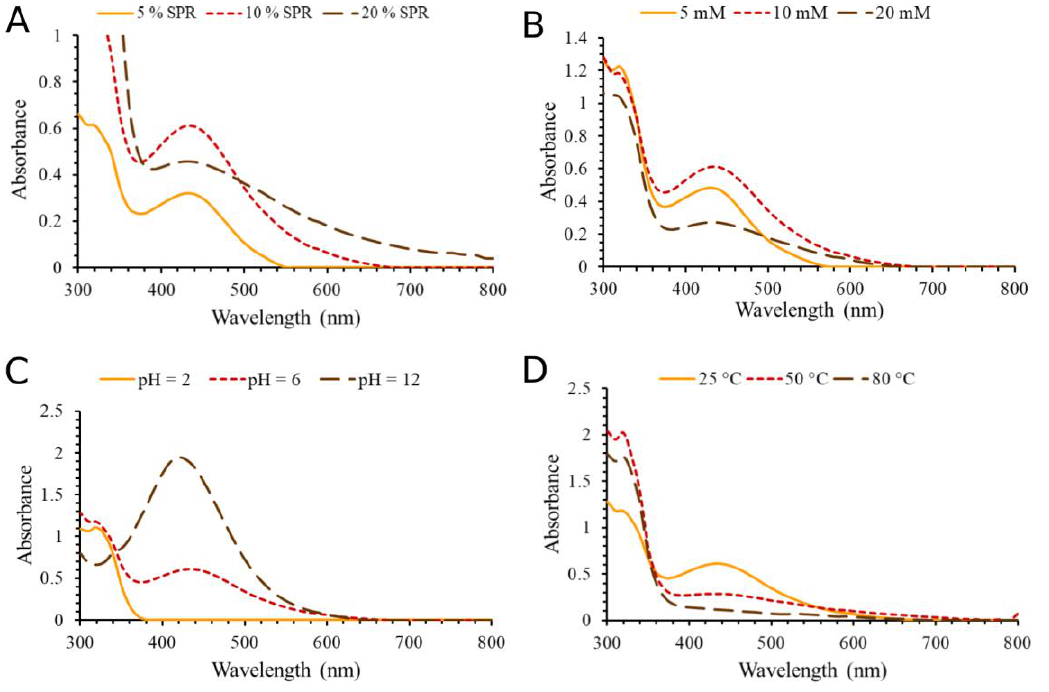
Figure 2. Influences of different parameters on the synthesis of SPR-AgNPs. ( A ) Extract concentra- tions, ( B ) AgNO 3 concentrations, ( C ) pH value, and ( D ) temperature.